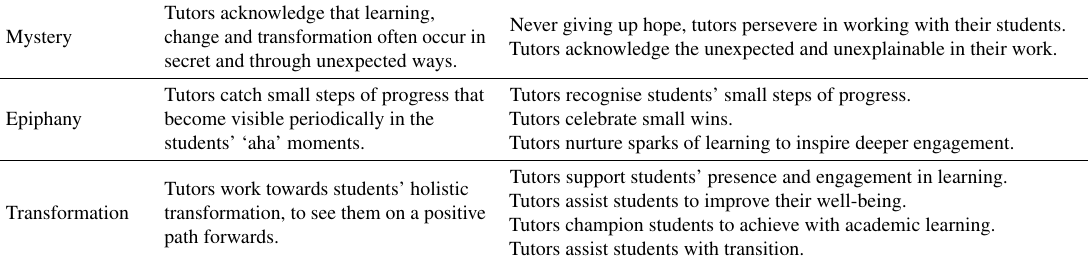
Table 4. Tutor achievement (Schoone, 2016, p,